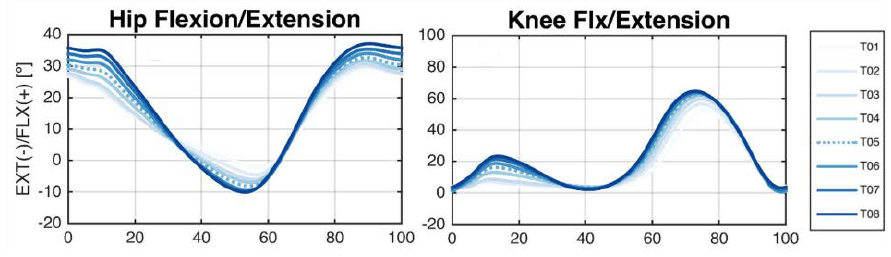
Fig. 3 Comparison of left foot data and waist data.